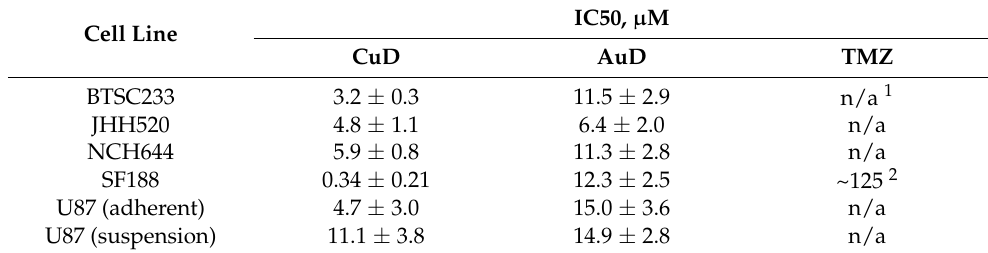
Table 1. IC50 values of metallodendrons and temozolomide